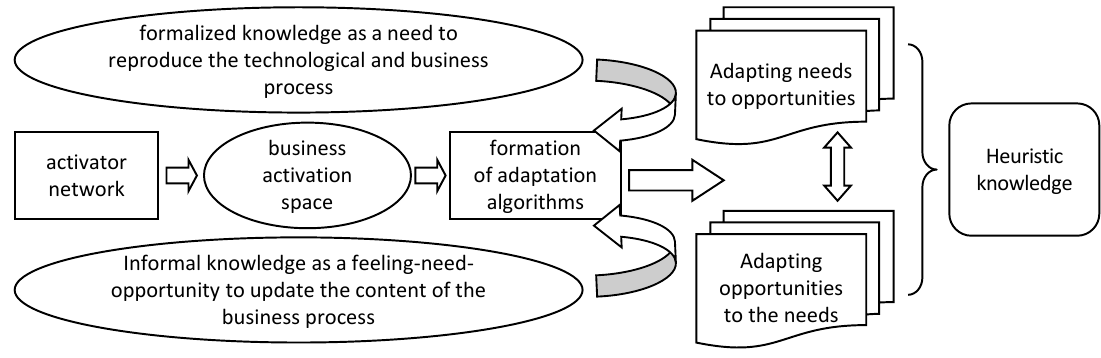
Figure 2. Innovation-production cycle of the activator of innovative